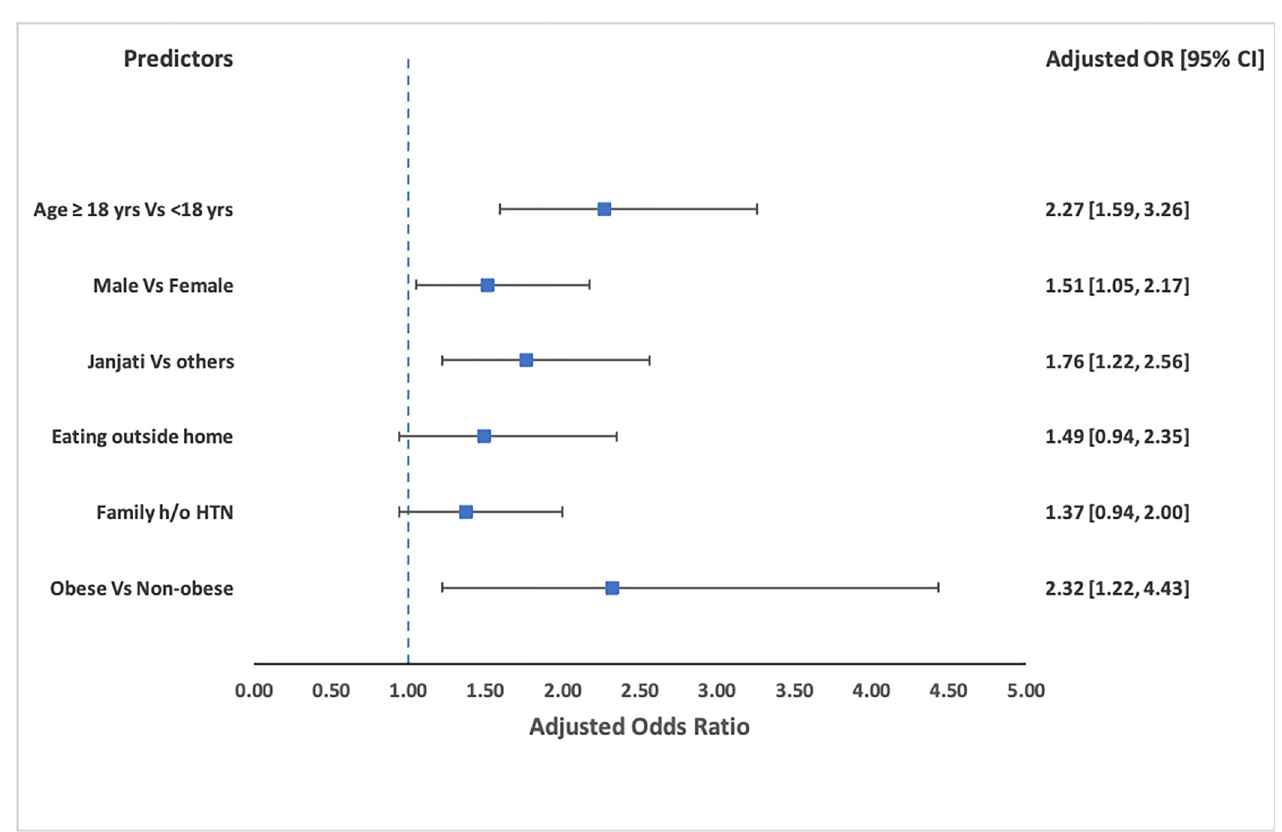
Fig 3. Adjusted odds ratio of predictors of PHTN based on final model (Model II).